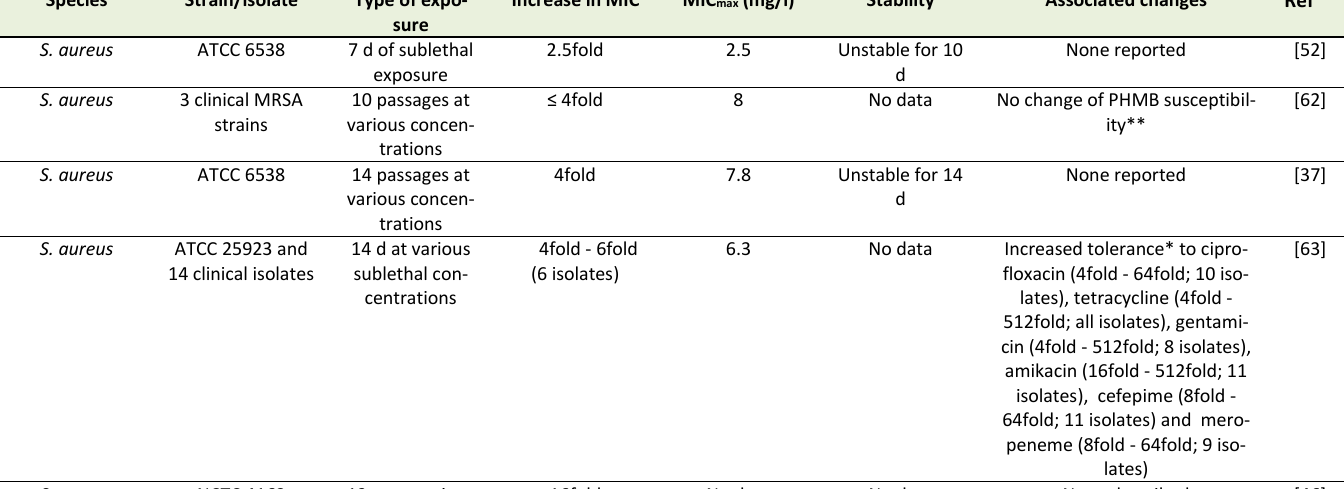
TABLE 2 (continued): Adaptive response of Gram-positive bacterial species to sublethal CHG exposure, adapted from